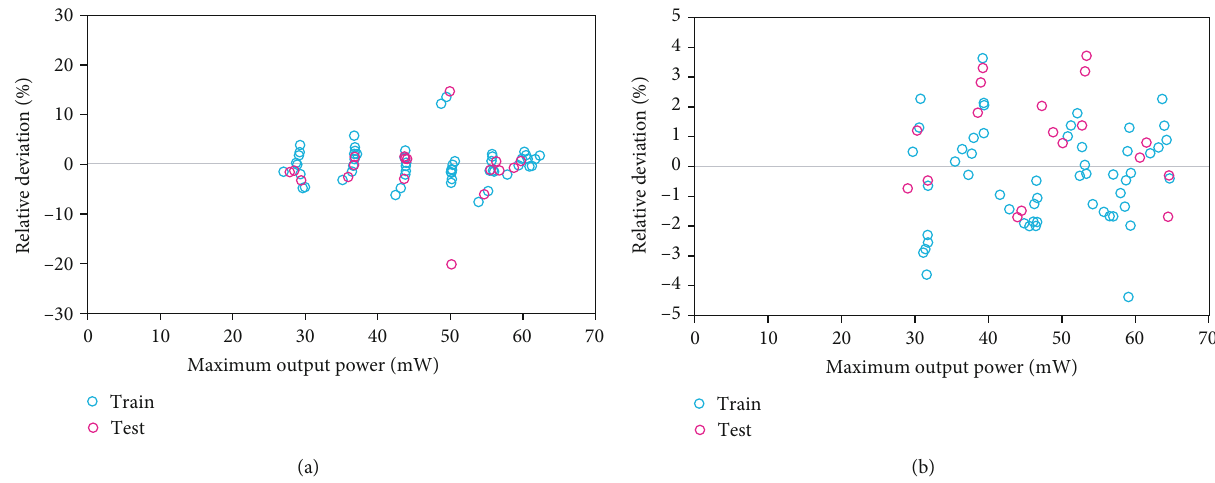
Figure 7: The relative deviation between experimental and predicted maximum output power by ANFIS for (a) monocells and (b)